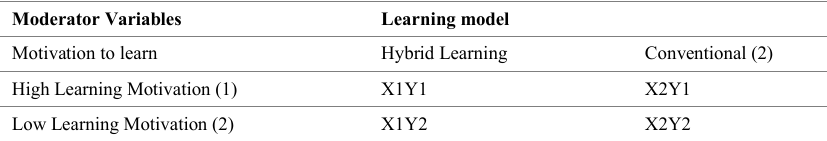
Table 4. Dimensions and Indicators of learning motivation.